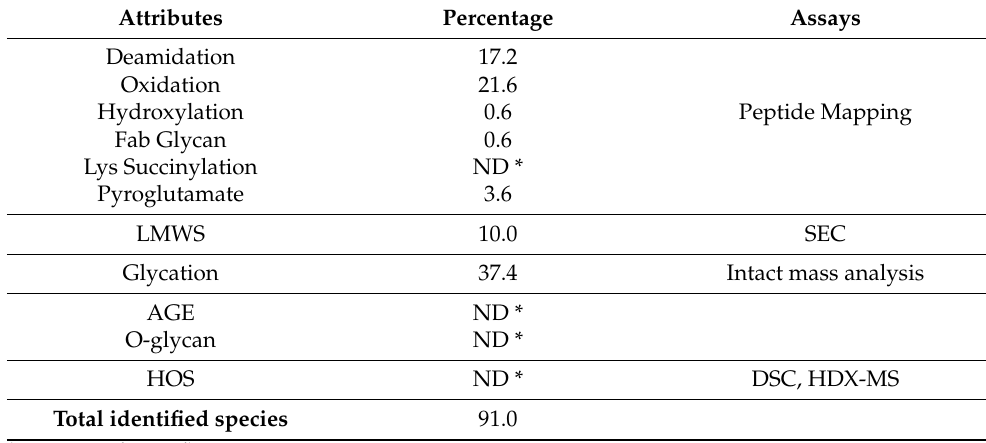
Table 1. Summary of Identified Acidic Variants in mAb1. Attributes Percentage Assays Deamidation 17.2 Oxidation 21.6 Hydroxylation 0.6 Peptide Mapping Fab Glycan 0.6 Lys Succinylation ND * Pyroglutamate 3.6 LMWS 10.0 SEC Glycation 37.4 Intact mass analysis AGE ND * O-glycan ND * HOS ND * DSC, HDX-MS Total identified